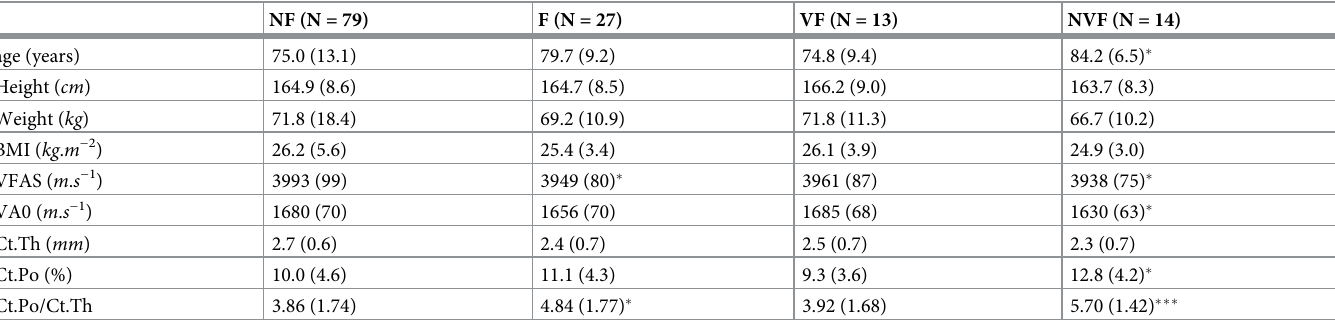
Fig 2. BDAT measurement failure rate and distribution for BMI and age, for the first population (106 patients). https://doi.org/10.1371/journal.pone.0277831.g002 Table 1. Descriptive characteristics as mean and standard deviation for the first population (106